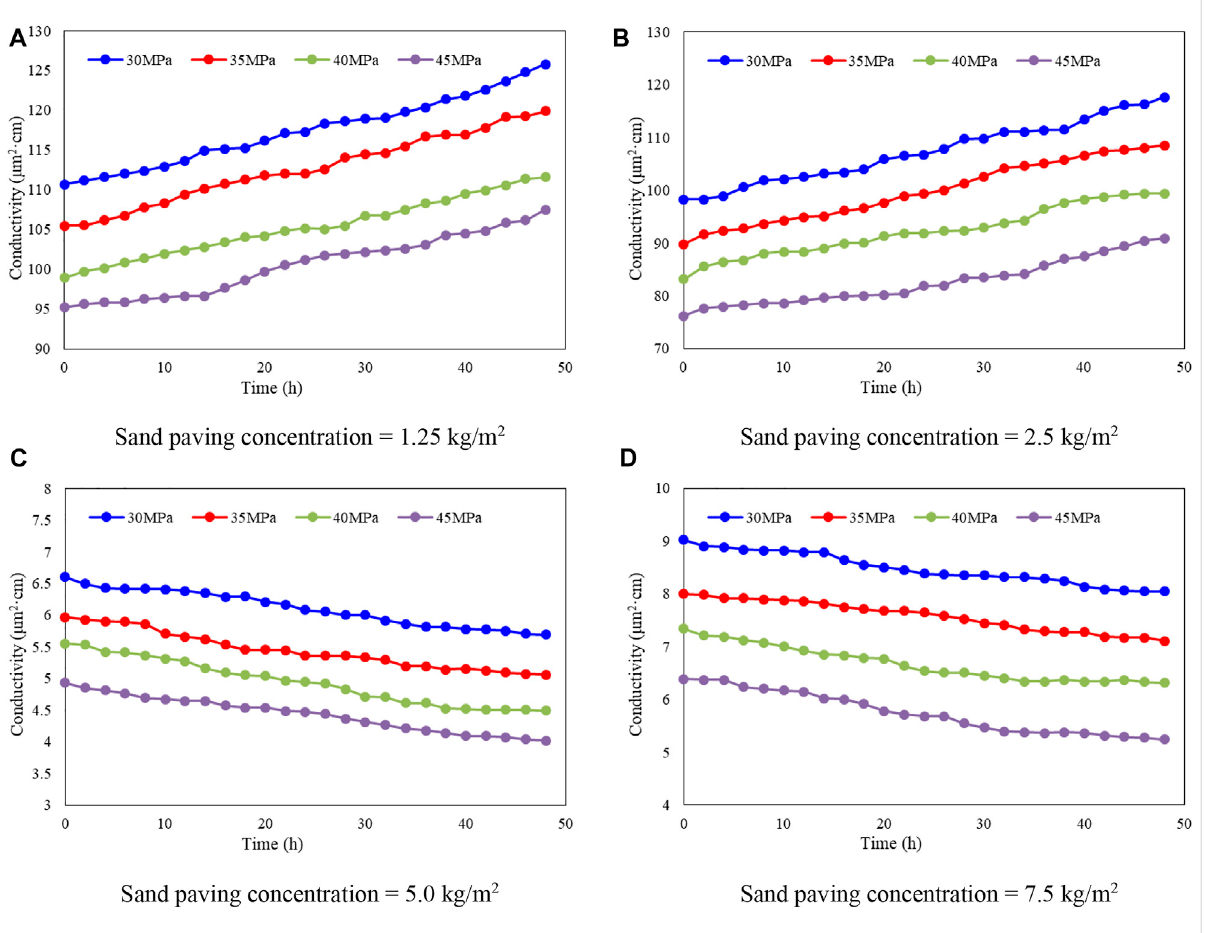
FIGURE 11 The proppant conductivity of CF 70 – 140 at different sand paving concentrations and different closure